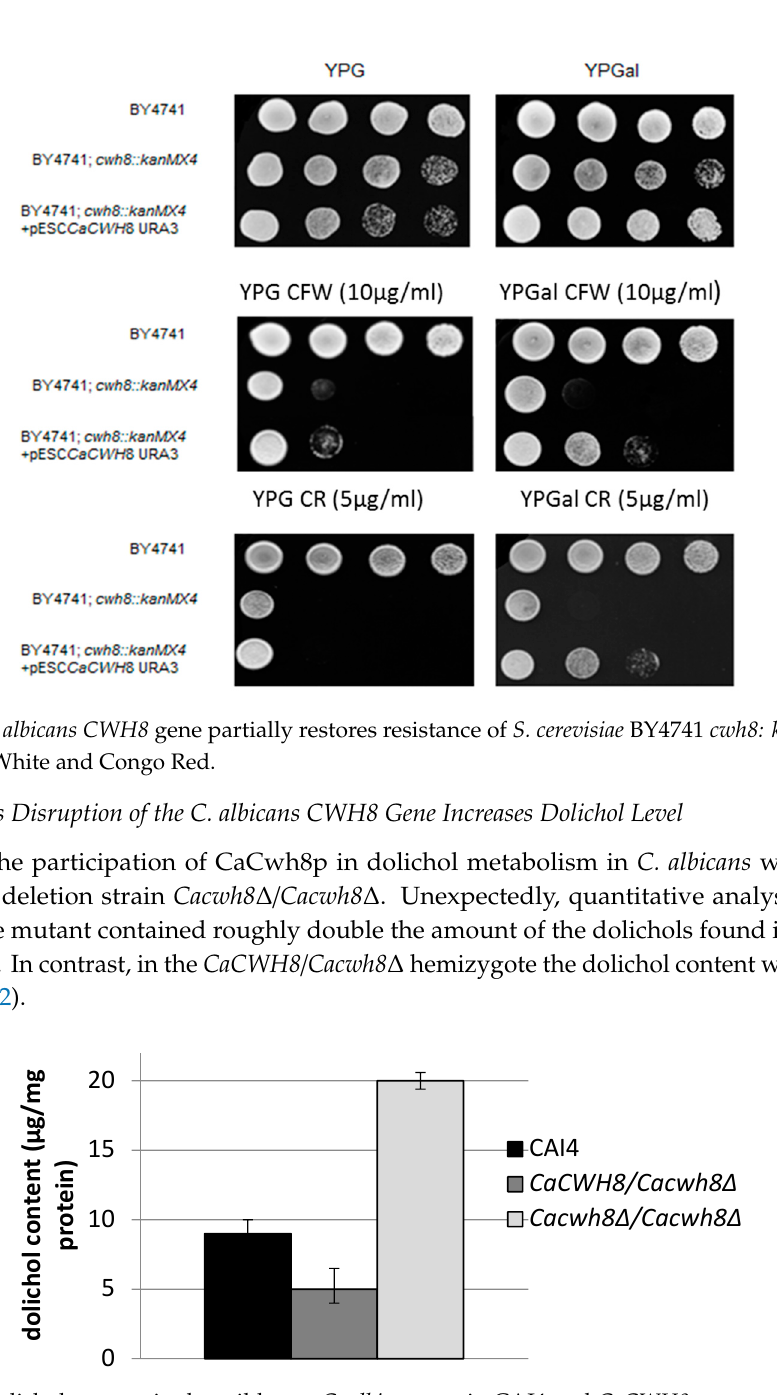
Figure 2. Dolichol content in the wild type C. albicans strain CAI4 and CaCWH8 mutants. Data are mean ± standard deviation from three independent experiments.